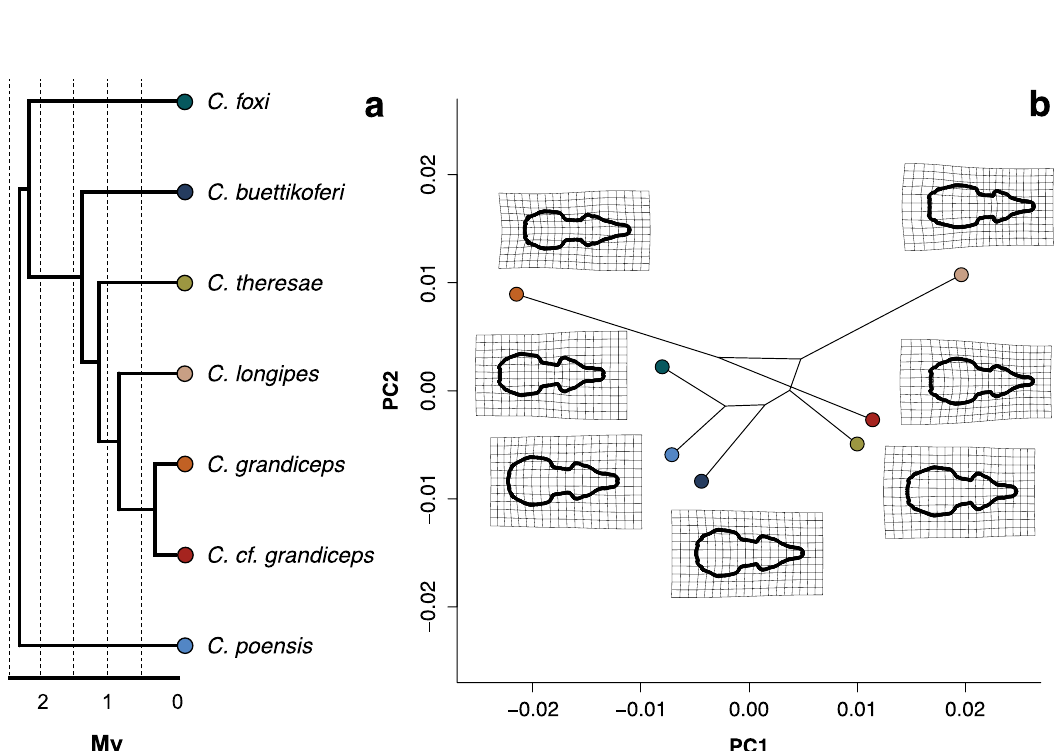
Figure 3. Species tree and phylomorphospace of the C. poensis species complex (only species with a specimen count ≥ 9 are shown). ( a ) Dated truncated species tree. ( b ) Phylomorphospace plot of PC1 and PC2 axes, for the same species. Values are based on species means. Deformation grids represent the mean for the species, relative to the mean for the whole data set, and amplified by a magnification factor of